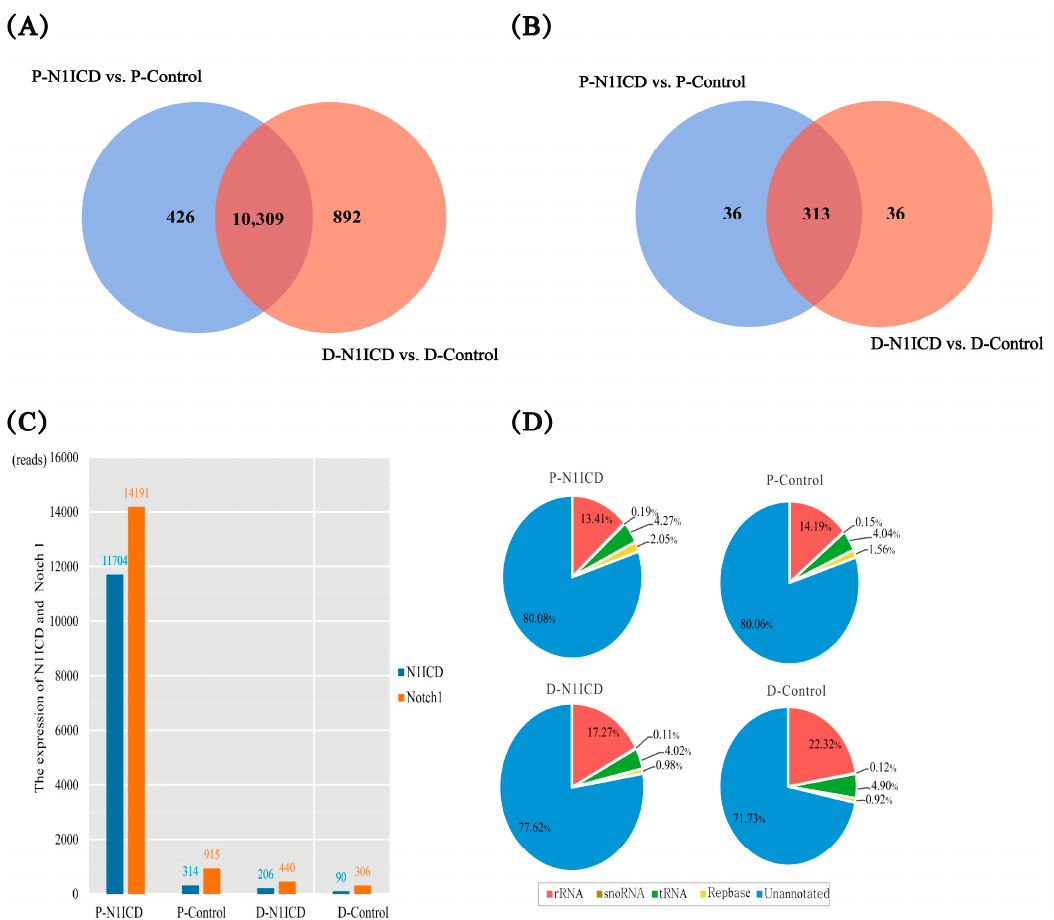
Figure 2. Gene and miRNA screening. ( A ) Number of genes expression; ( B ) Number of miRNAs expression; ( C ) Expression of N1ICD and Notch1 estimated by BLAST (Basic Local Alignment Search Tool); ( D ) Classification of the annotation of small RNA.